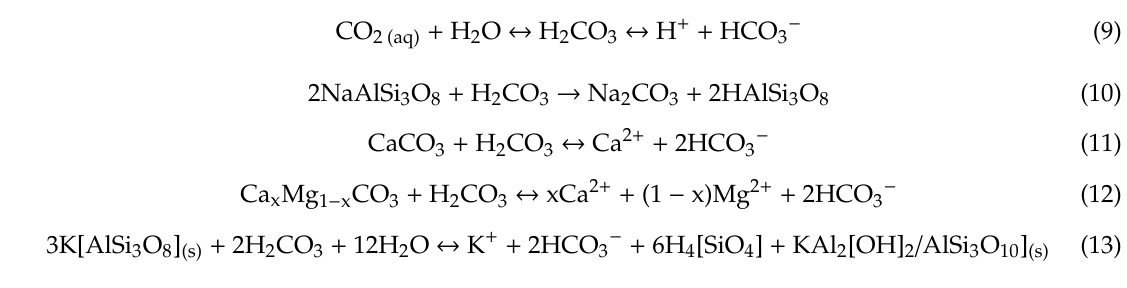
Table 3. Mineral content vs. the varied Sc-CO 2 flooding time.